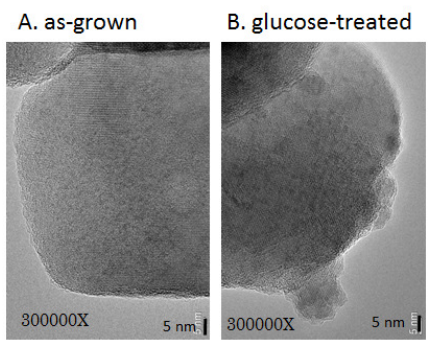
Figure 3. Transmission electron microscopy (TEM) images of ( a ) as-grown and ( b ) glucose-treated